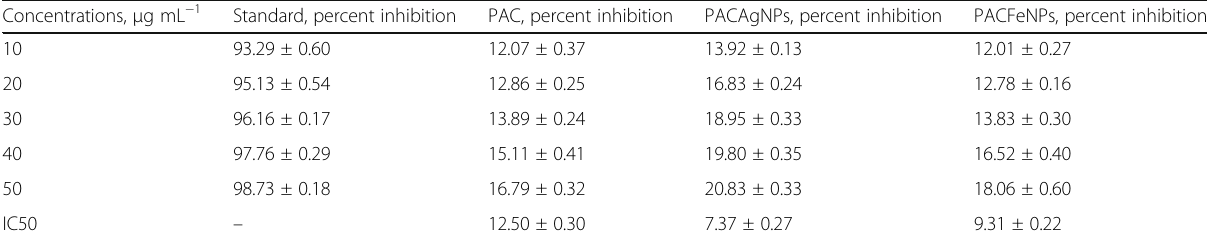
Table 4 Antioxidant activity of DPPH radical-scavenging activity Concentrations, μ g mL −